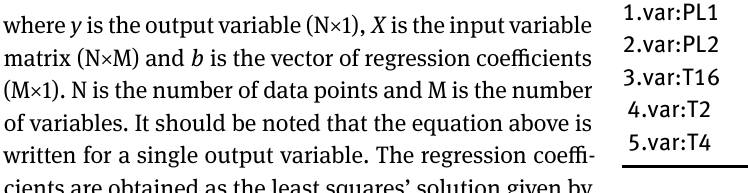
Table 2: Selected variables and modelling result for booster